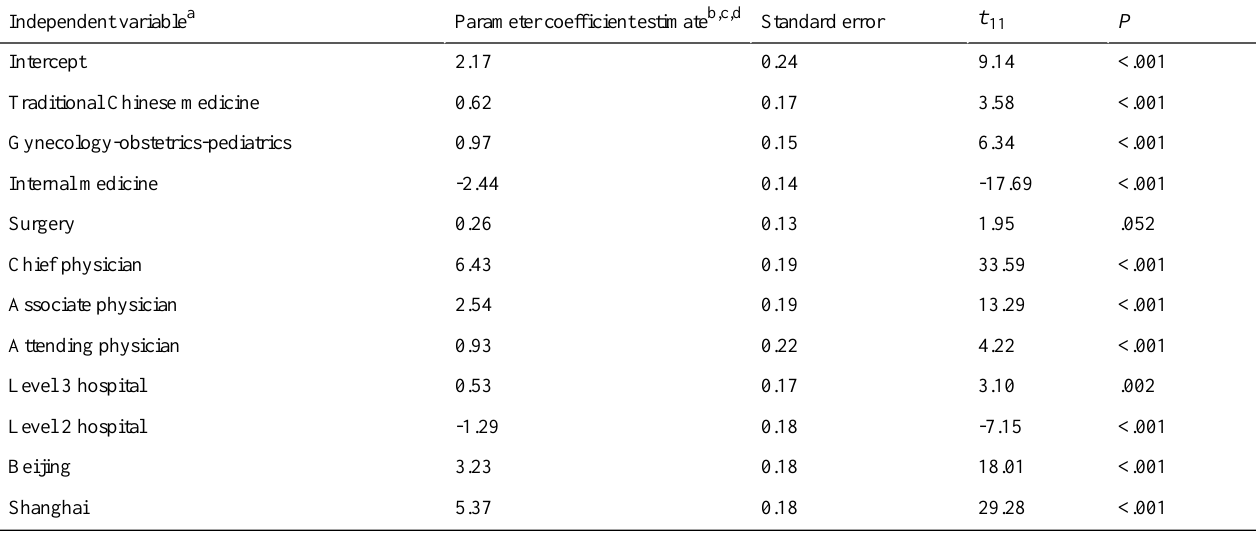
Table 4. Results for linear regression for doctors in different areas receiving reviews